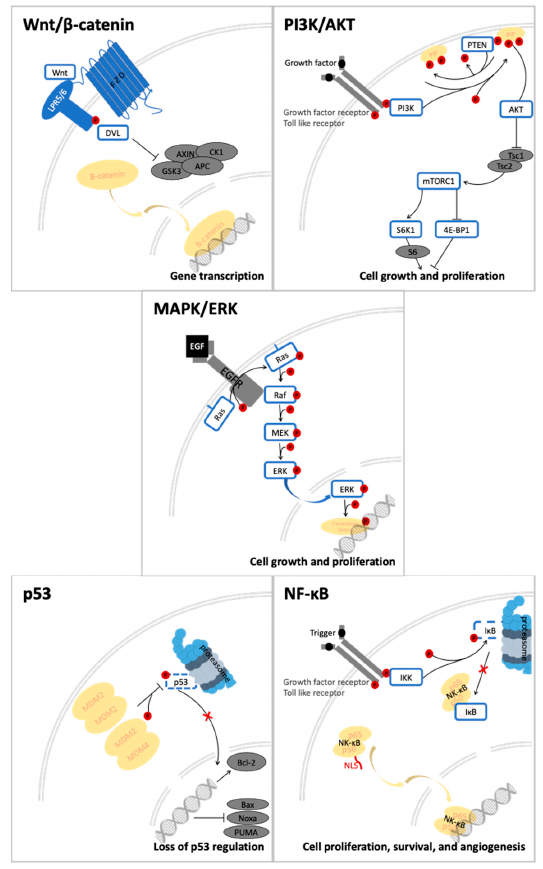
Figure 4. Signal transduction pathways in CRC that are modulated by quercetin: Wnt/ β -catenin, PI3K/AKT, MAPK (using MAPK/ERK as an example for the phosphorylation cascade), p53, and NF- κ B.